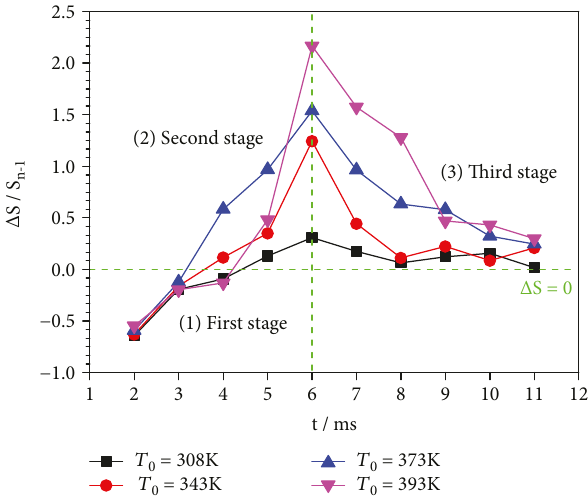
Figure 6: In fl uence of air fl ow temperature on fl ame structure. Figure 7: E ff ect of air temperature on the growth rate of fl ame